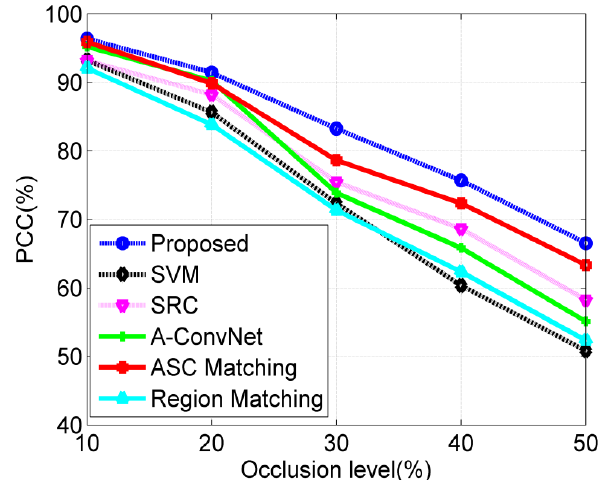
Figure 14. Performance comparison of all the methods under partial occlusion.